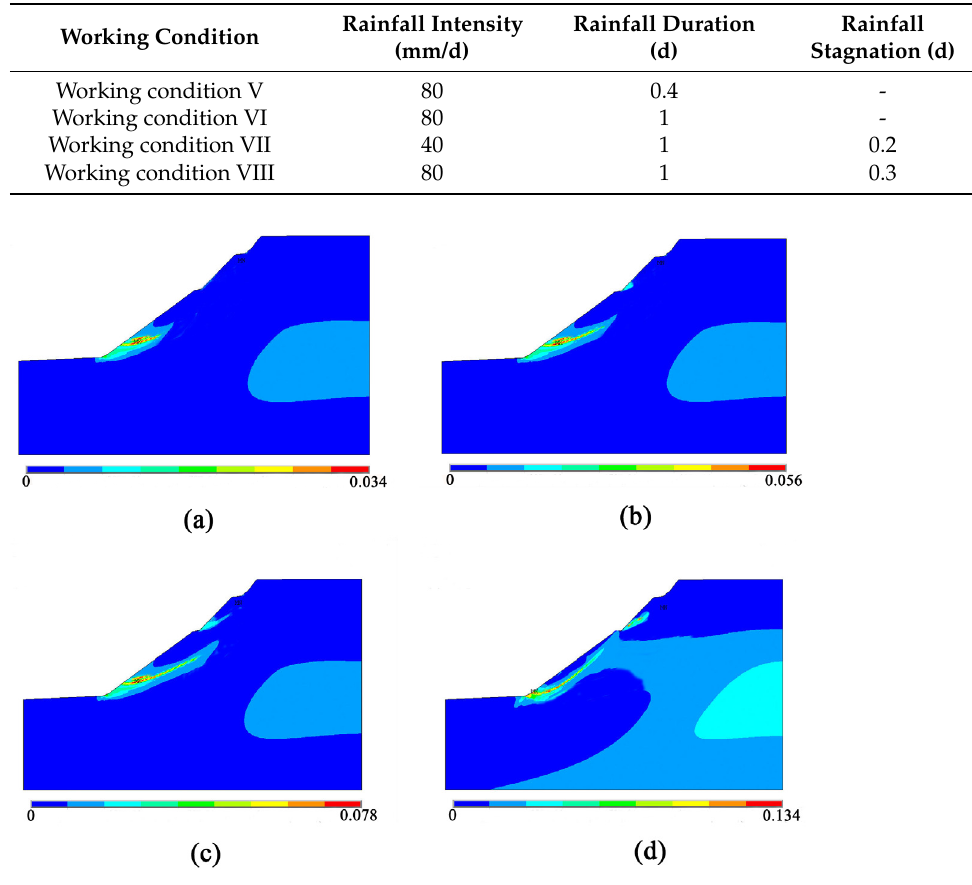
Table 3. Rainfall design table under different working conditions of rainfall stagnation.